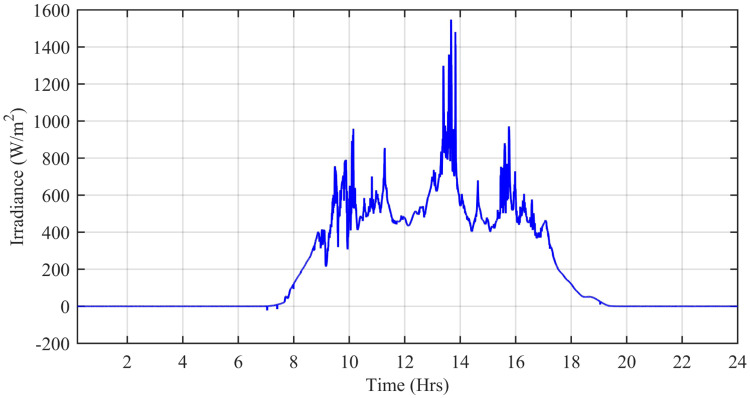
Solar irradiance level (W/m2.